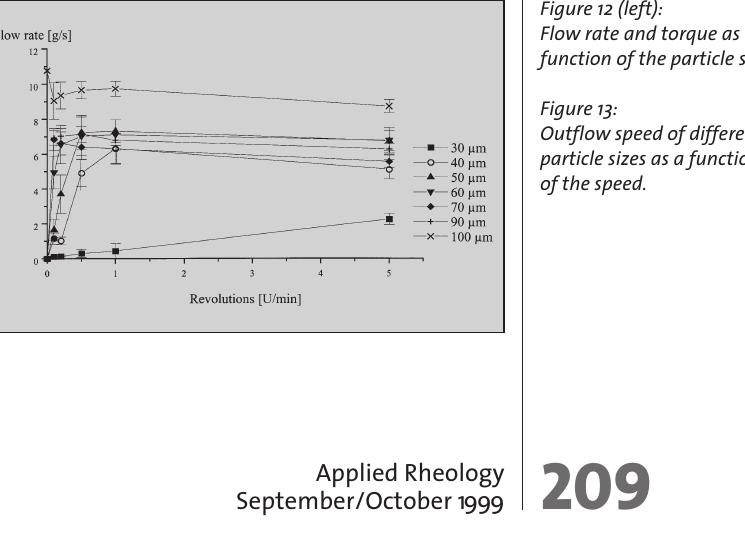
Figure 12 (left): Flow rate and torque as a function of the particle size. Figure 13: Outflow speed of different particle sizes as a function of the